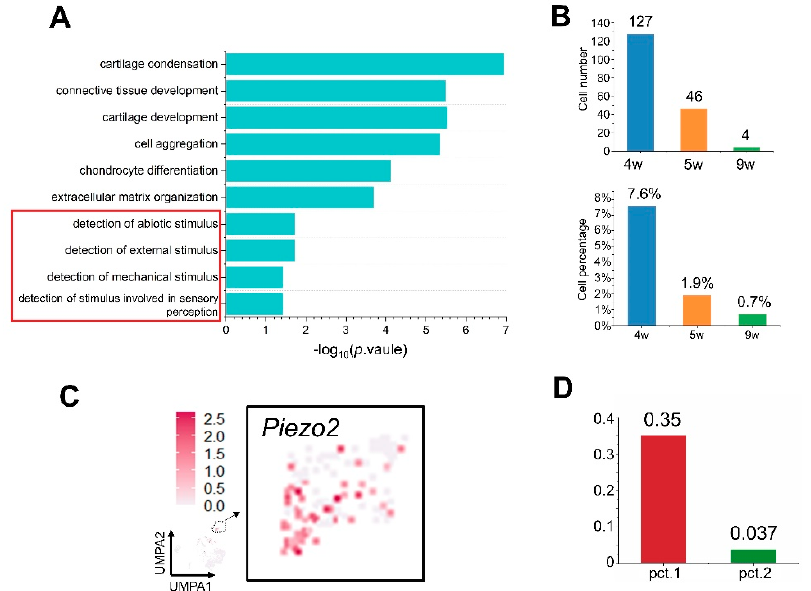
Figure 4. Identification of Piezo2 + chondrogenic mesenchymal cells by scRNA-seq (mouse model). ( A ) Bar graph showing the enriched gene ontology terms of chondrogenic mesenchymal cells. ( B ) Bar graph showing the cell numbers and percentage of chondrogenic mesenchymal cells. ( C ) Feature plots showing the expression of Piezo2 + mesenchymal cells. Additionally, feature plots of Piezo2 + chondrogenic mesenchymal cells have been magnified and are visualized on the magnified UMAP and color coded by the expression level of Piezo2 . ( D ) Bar graphs showing pct.1 and pct.2 of Piezo2 + of chondrogenic mesenchymal cells calculated with